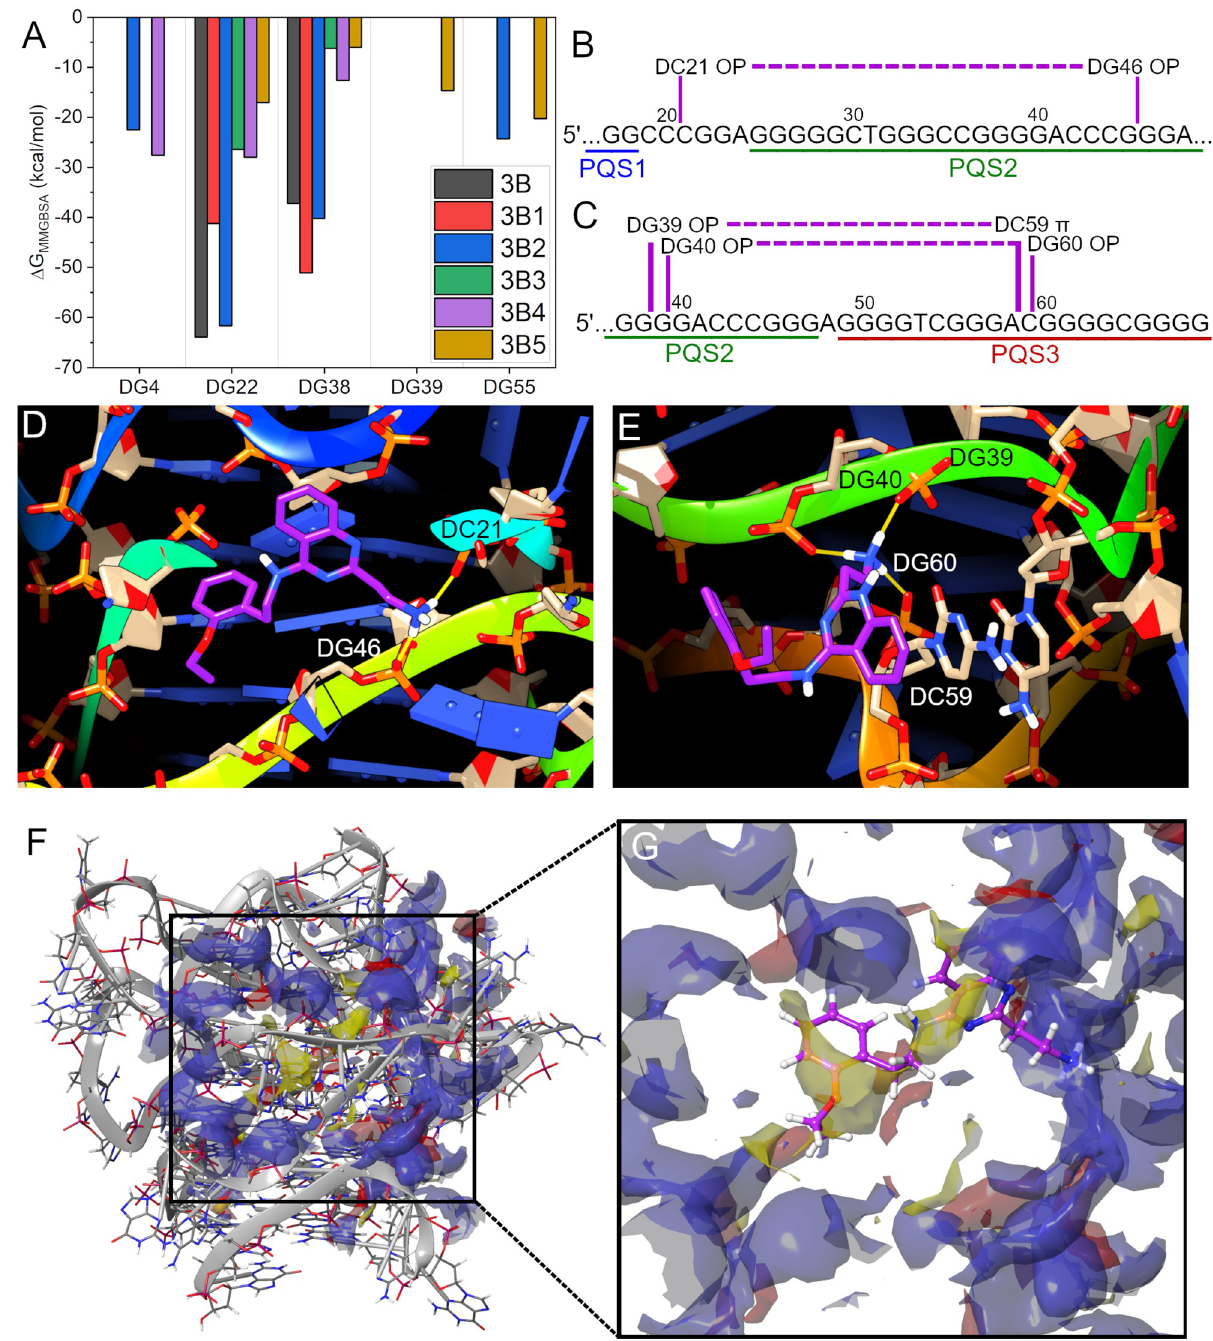
Fig 5. Glide XP docking and post-MD interactions of 3B1 with the higher-order hTERT G4. (A) Summary of free energies calculated for each derivative at each docking site. The site names “DG#” are used to distinguish where on the quadruplex the compounds were docked. Values are theoretical free energies of binding using the implicit GBSA model calculated over 5 ns of production simulation in explicit solvent. (B, C) Schematic representations of the regions of the hTERT G4 sequence where 3B1 is predicted to bind. The purple lines and dashes are used to illustrate that in docking site “DG22” (D), the 3B1 binding site spans PQS1 and PQS2 regions, and at site “DG38” (E), 3B1 spans PQS2 and PQS3 via phosphate backbone and stacking interactions. (F) The hTERT higher-order G4 with DG22 SiteMap region overlaid. The phosphate backbone is shown as gray ribbons with PQS1 (the 5’ end) at the top. Ligand donor, ligand acceptor, and hydrophobic regions are shown as blue, red, and yellow, respectively. (G) The SiteMap region blown up with 3B1 overlaid in purple as ball and stick representation. The hydrophobic regions of 3B1 are situated within the predicted hydrophobic pocket (yellow), with its hydrogen donating nitrogens near or within the predicted ligand donor regions and its ether oxygen near a ligand acceptor region.